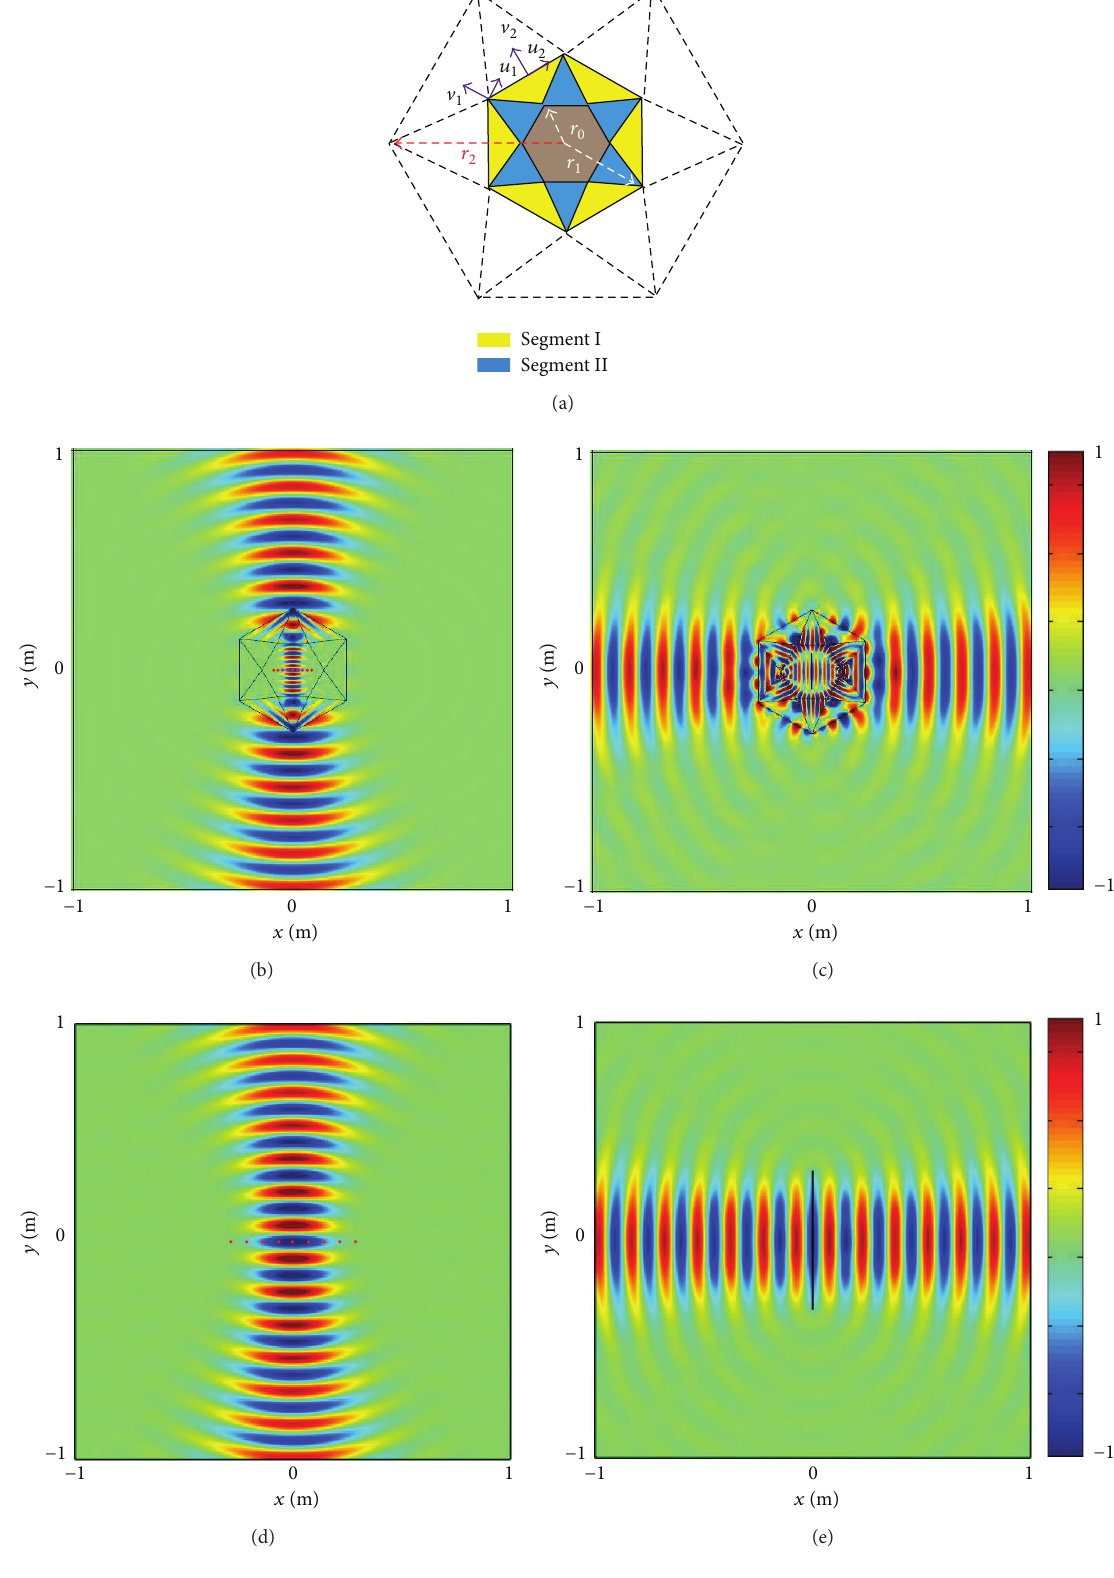
Figure 4: (a) The structure of a hexagonal metamaterial shell. (b) 𝐸 𝑧 field distribution of a small antenna array with nine elements embedded in hexagonal metamaterial shell. (c) 𝐸 𝑧 field distribution of a small current plane embedded in hexagonal metamaterial shell. The z -directed electrical field distributions of (d) large size antenna array and (e) large size current plane in free